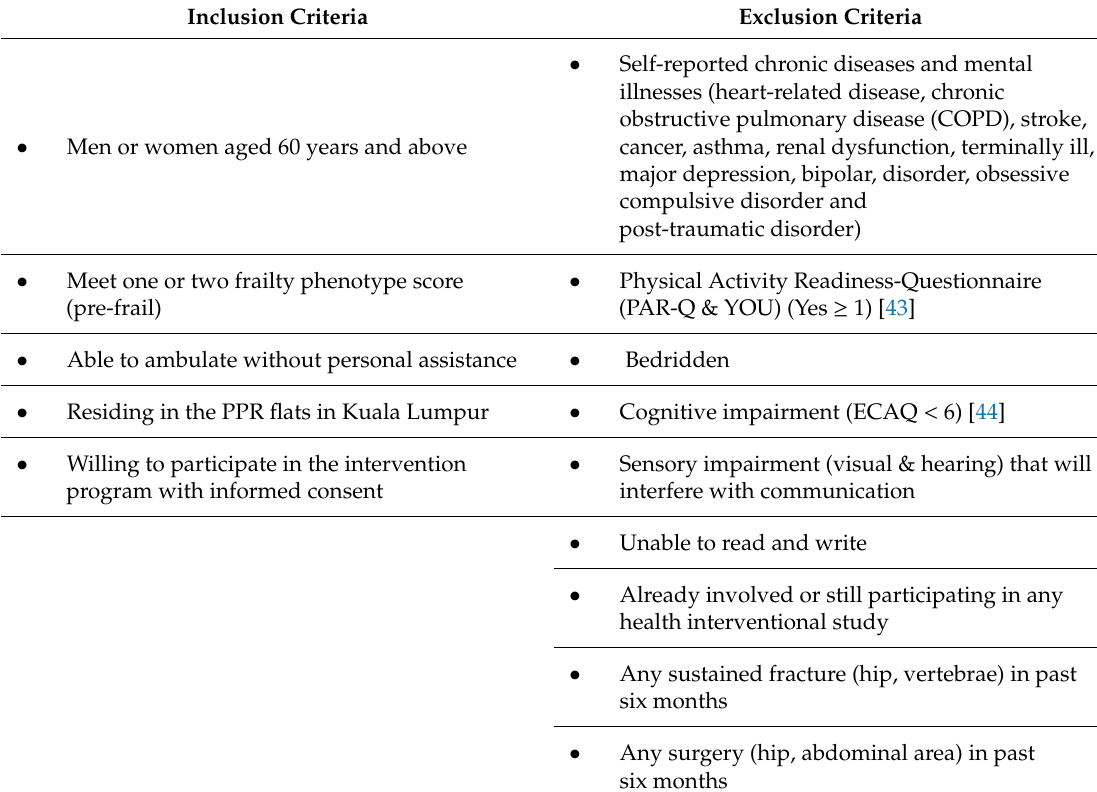
Table 1. The summary of the inclusion and exclusion criteria for the Frailty Intervention through Nutrition Education and Exercise (FINE)